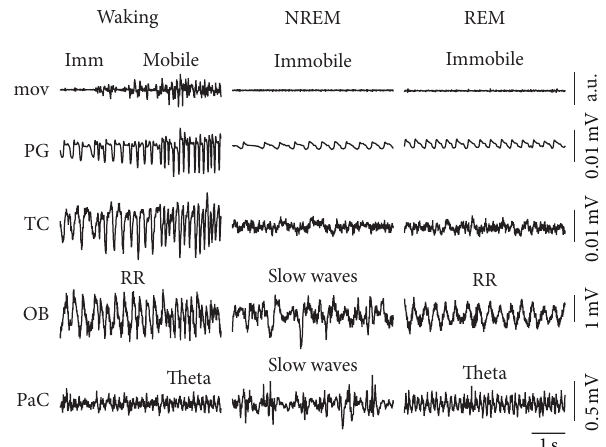
Figure 1: Examples of three vigilance states: waking, nonrapid eye moving (NREM), and rapid eye moving (REM) sleep. Three signals are sufficient for vigilance staging: (1) movement (mov) detection based on accelerometer activity; (2) detection of slow waves in parietal cortex (PaC), and (3) detection of theta (4–12Hz) oscilla- tions in the PaC reflecting activity in the underlying